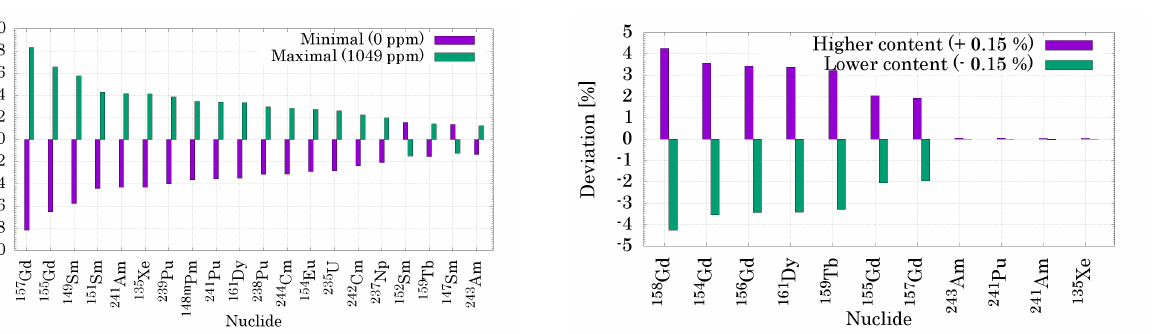
Figure 5. Effect of change in boron content on com- position.